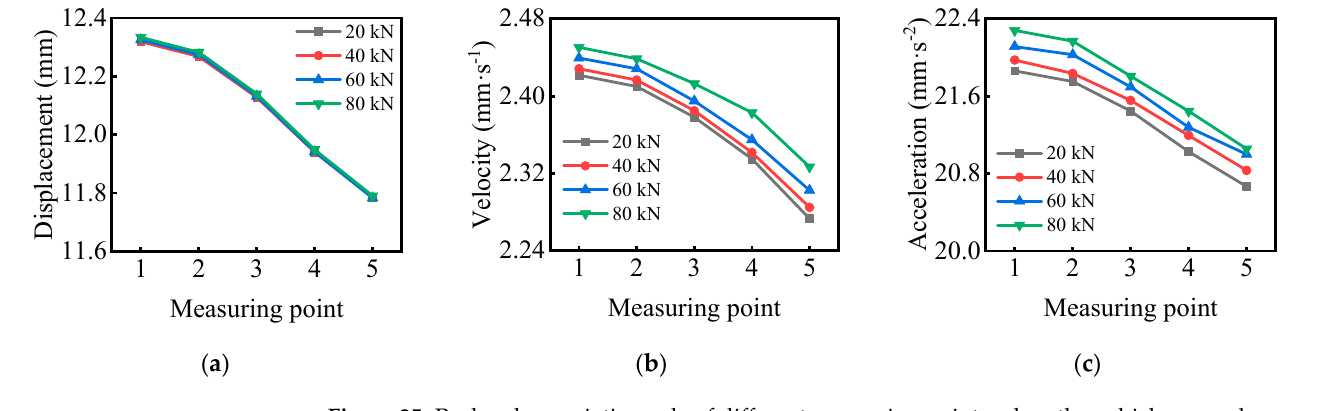
Figure 25. Peak value variation rule of different measuring points when the vehicle mass changes ( a ) displacement, ( b ) velocity, and ( c ) acceleration. Table 8. Results of peak displacement, velocity, and acceleration at the mid − span measuring point when the vehicle mass changes.